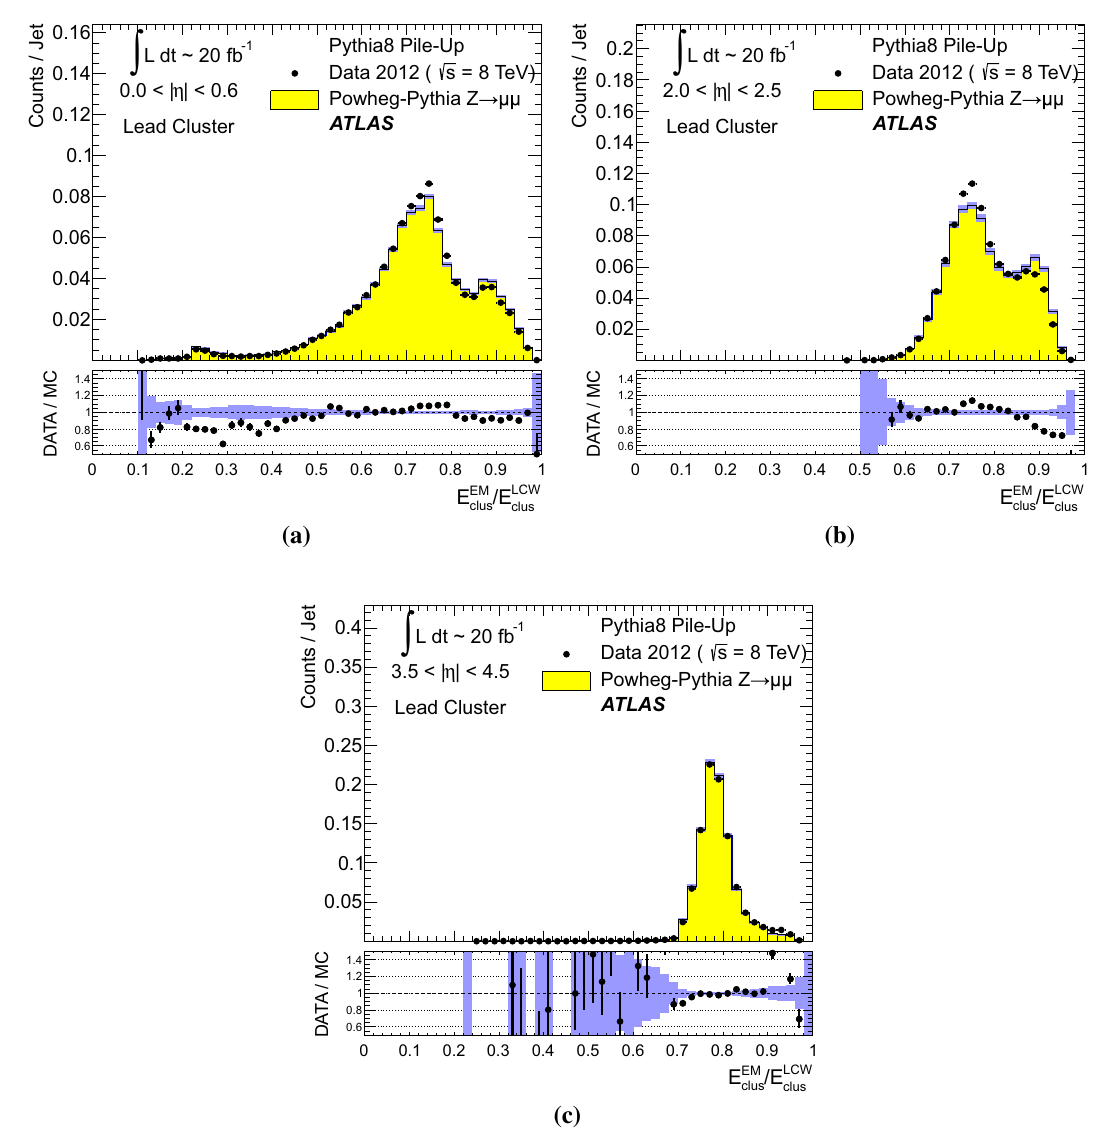
Fig. 38 The distribution of the ratio of the cluster signal reconstructed to MC simulations with fully simulated pile-up for Z → μμ events recorded in 2012. The ratio of the distribution from data to the one from on EM scale E EM to the fully calibrated signal E LCW for the leading clus clus MC simulations is shown below each plot. The shaded bands show sta- topo-cluster in fully calibrated jets reconstructed with the anti- k t algo- < 40GeV in regions of tistical uncertainties for the distributions from MC simulations and the rithm with R = 0 . 4 and 30GeV < p LCW + JES T , jet a the central ( | η jet | < 0 . 6), b the end-cap (2 . 0 < | η jet | < 2 . 5), and c the corresponding uncertainty bands in the ratio plots. The reference scale for ρ clus is ρ 0 = 1MeV / mm 3 , and for the energy E 0 = forward (3 . 5 < | η jet | < 4 . 5) calorimeters in ATLAS. Data is compared